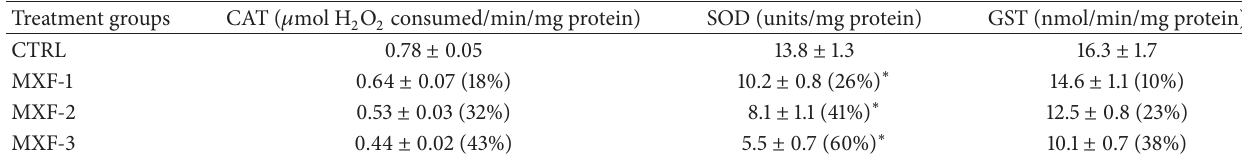
Table 3: Influence of MXF on the activities of hepatic antioxidant enzymes in rat. Treatment groups